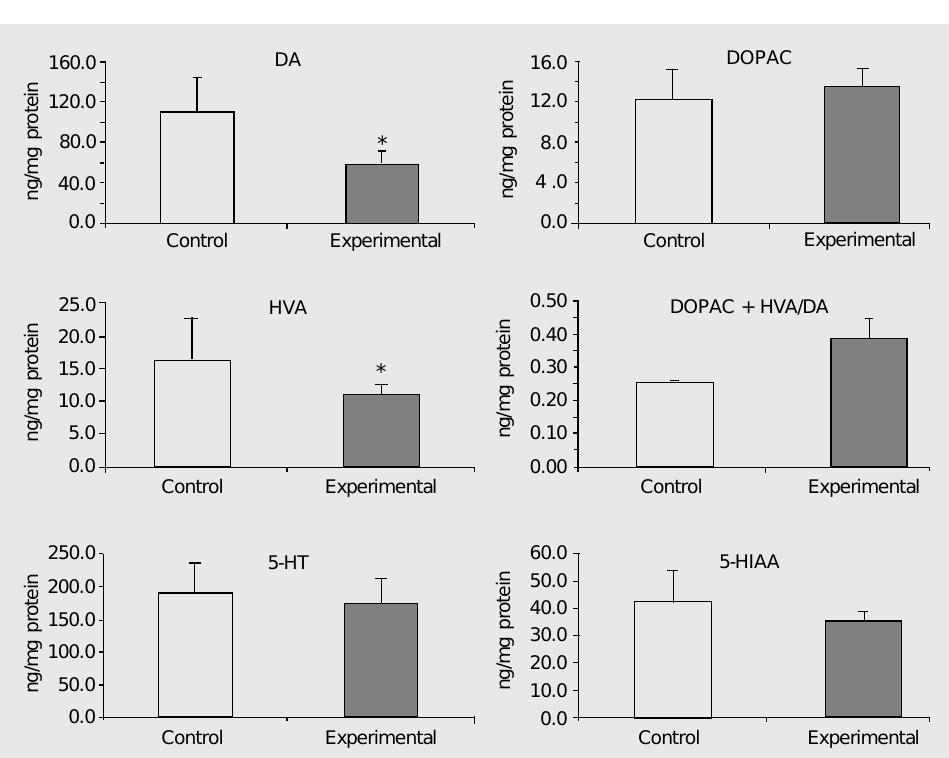
Figure 5. Number of catechola- minergic tyrosine hydroxylase (TH)-labeled neurons of the sub- stantia nigra pars compacta (A, SNpc) and of the ventral teg- mental area (B, VTA) of mice 21 days post-inoculation of 5 x 10 6 colony forming units of Nocardia otitidiscaviarum (GAM-5) (exper- imental) and of non-infected mice (control). The small bars represent the mean ± SEM (*P < 0.001 compared to control, Student t -----test). The Nocardia -in- fected mice showed a large re- duction in the TH-positive neu- rons in both the SNpc and in the VTA. However, the reduction was greater in the dopaminer- gic SNpc neurons, i.e., 58% compared to 35% in the VTA. Figure 6. Monoamine changes in the brain of NMRI mice at 21 days after a single intravenous injection of 5 x 10 6 colony form- ing units of Nocardia otitidisca- viarum (GAM-5) (experimental) and of non-infected mice (con- trol). The small bars represent the mean ± SEM. *P < 0.05 compared to control (Student t - test). DA = dopamine; DOPAC = dihydroxyphenylacetic acid; DOPAC + HVA/DA = DA turn- over; 5-HIAA = 5-hydroxyndol- acetic acid; 5-HT = serotonin; HVA = monovanillic